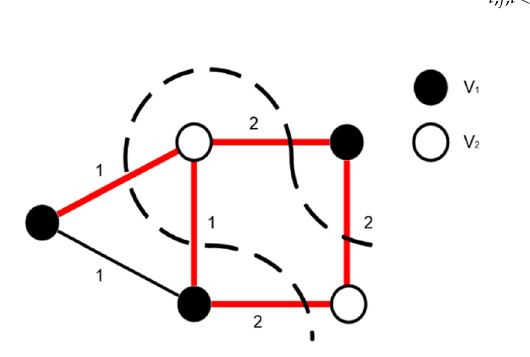
Figure 5. Schematic diagram of the max-cut problem.